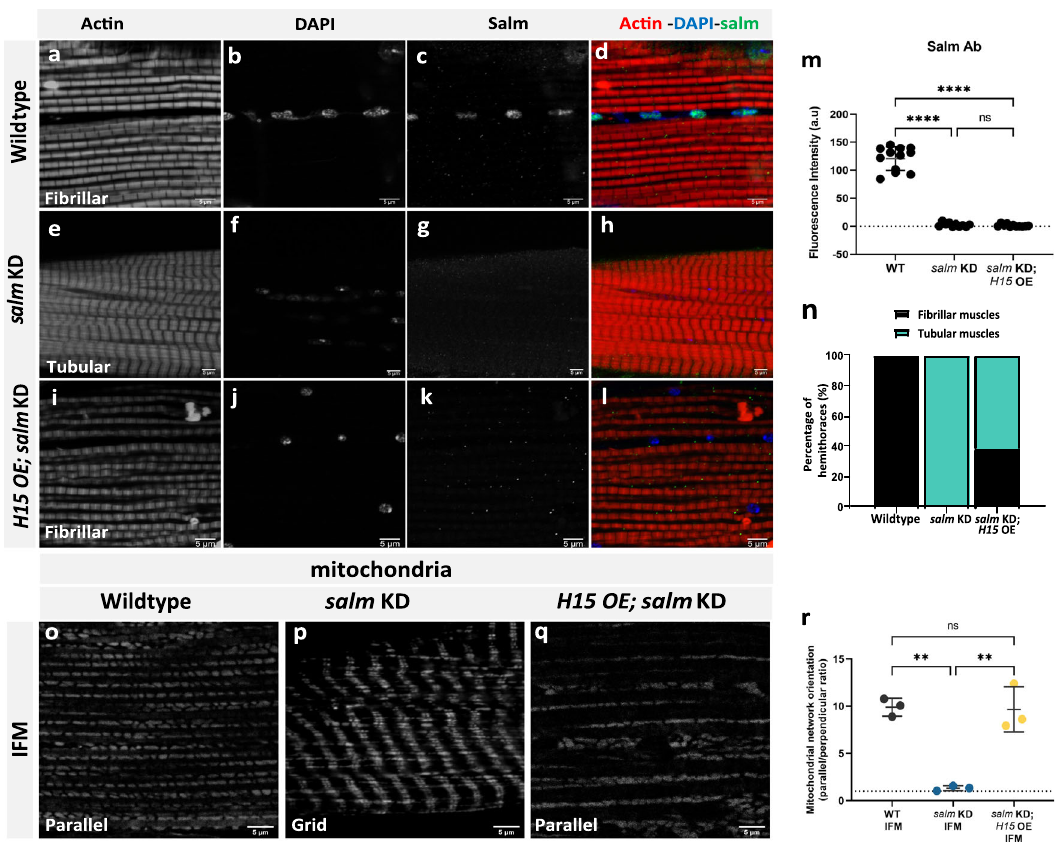
Fig. 5 | H15 is downstream of salm and H15 OE rescues fi ber-type switching in salm KD fi bers. a – d Wildtype fi brillar IFM stained for F-actin (phTRITC), nuclei (DAPI),andSalmantibodyshowingSalmexpressioninthenuclei. e – h salm KDIFM showing decreased expression of salmand fi bertypeswitchinIFMfrom fi brillarto tubular. i – l H15 OE; salm KD shows fi brillar fi ber type in IFMs and decreased Salm antibody immuno fl uorescence (Scale Bars: 5 μ m for all). m Quanti fi cation of fl uorescence intensity of Salm antibody staining (Wildtype, n =12, 3 animals; salm KD, n =11, 3 animals; H15 OE; salm KD, n =11, 4 animals). Each point represents the value for each dataset (Wildtype, n =16; salm KD ( UAS-salm RNAi;UAS-mito- gfp;mef2) (, n =20 animals; H15 OE; salm KD, n =26 animals). n Quanti fi cation of fi ber type in IFMs (Wildtype, n =16; salm KD ( UAS-salm